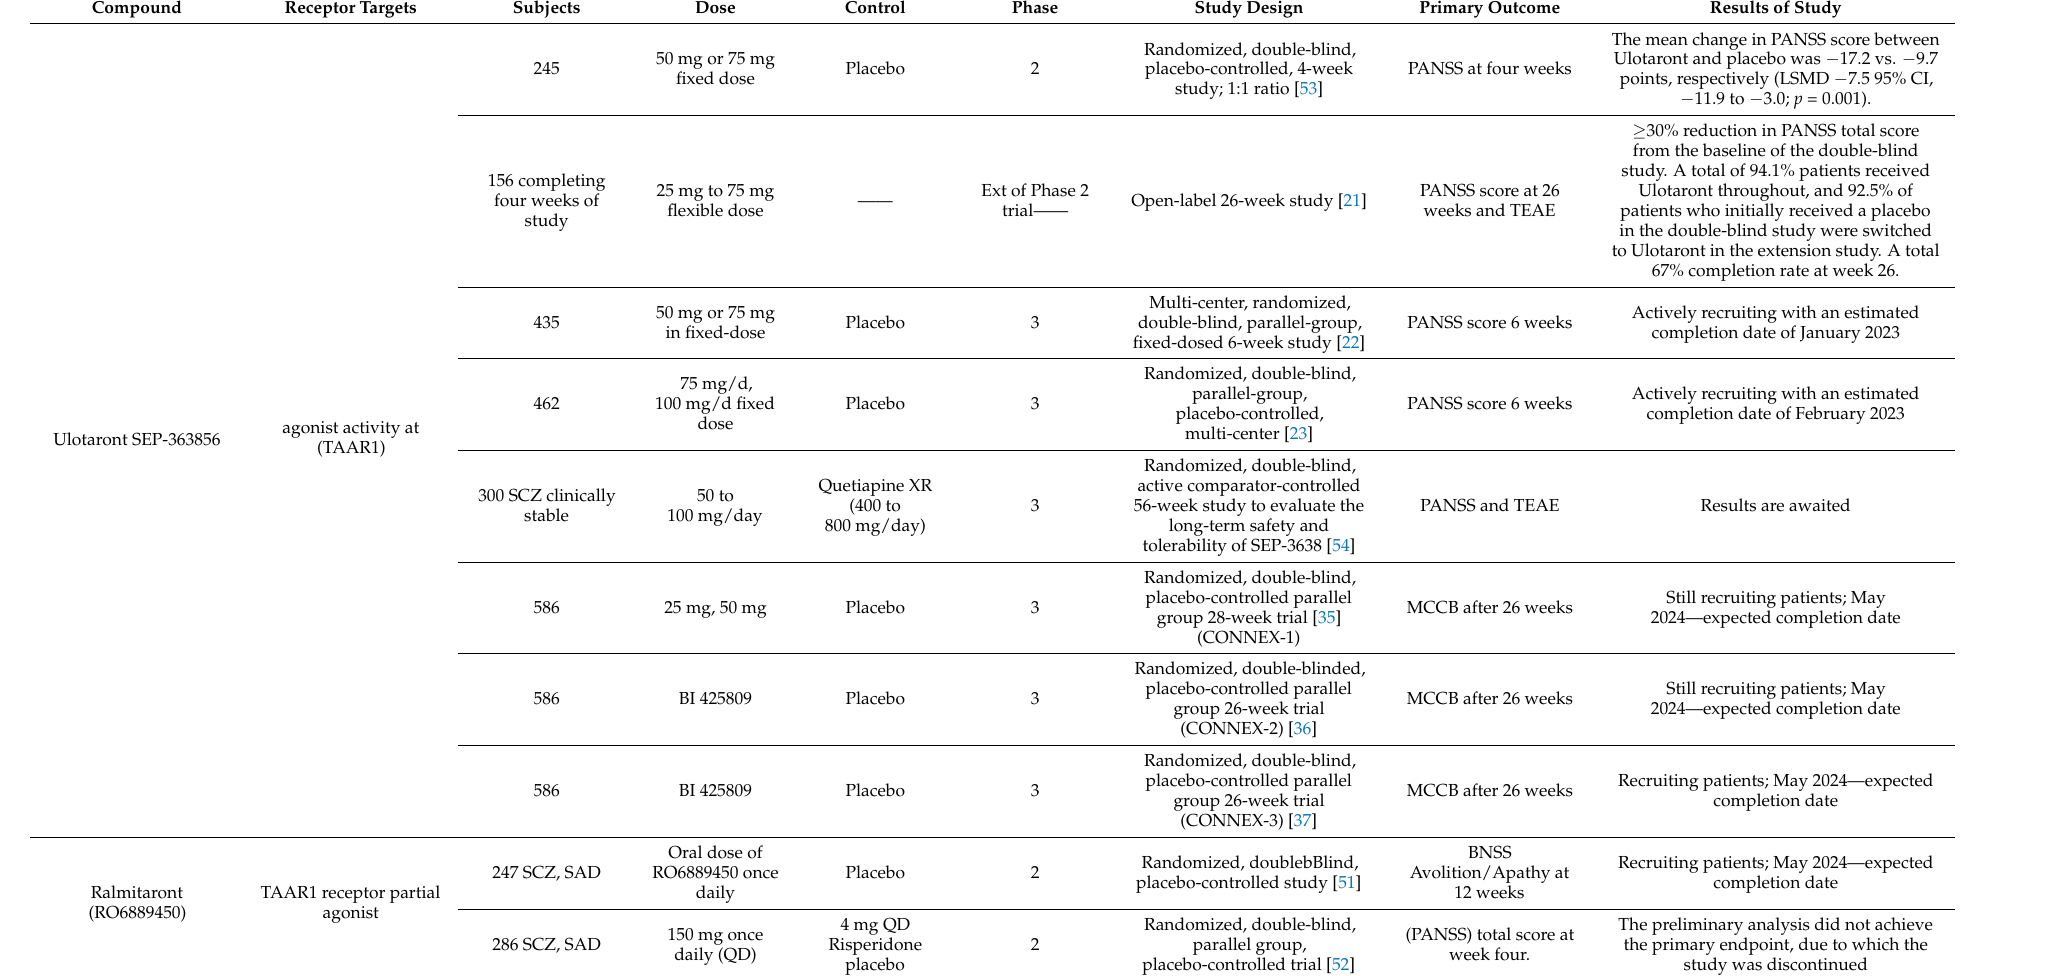
Table 5. Modulators of TAAR